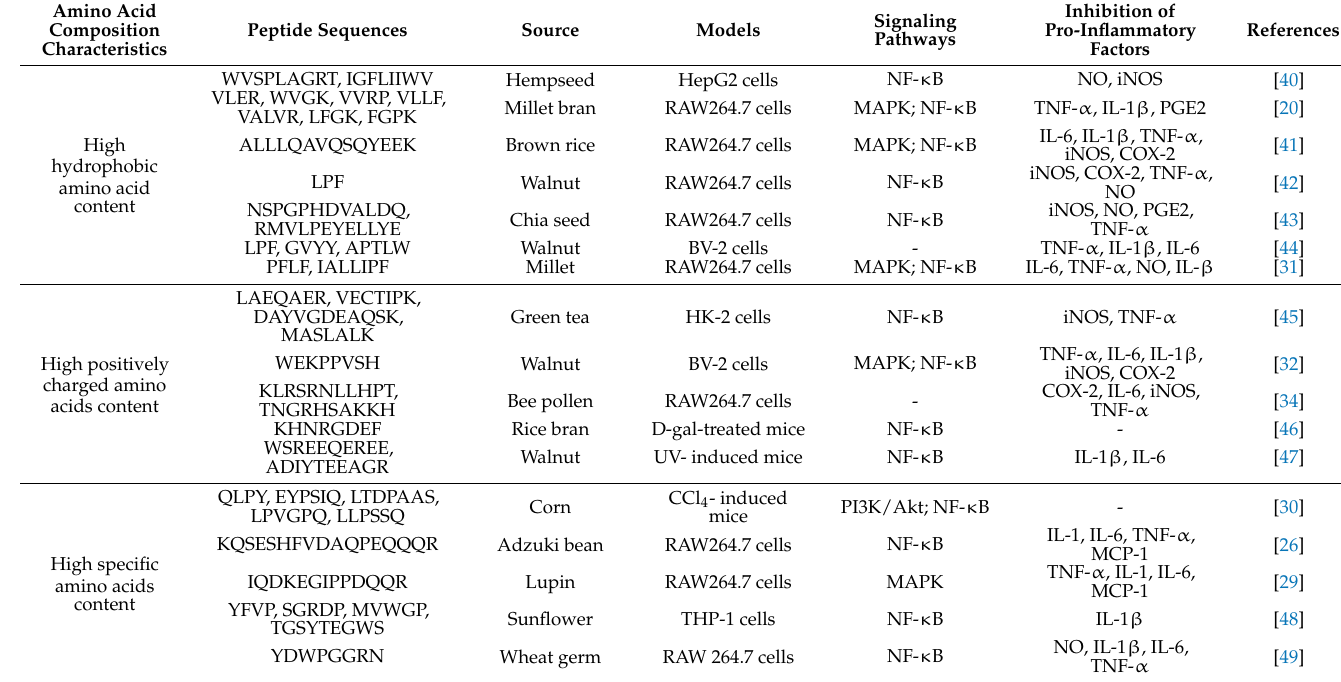
Table 1. Effects of amino acid composition on the anti-inflammatory properties of low-molecular- weight, plant-derived bioactive peptides (2020–2022).